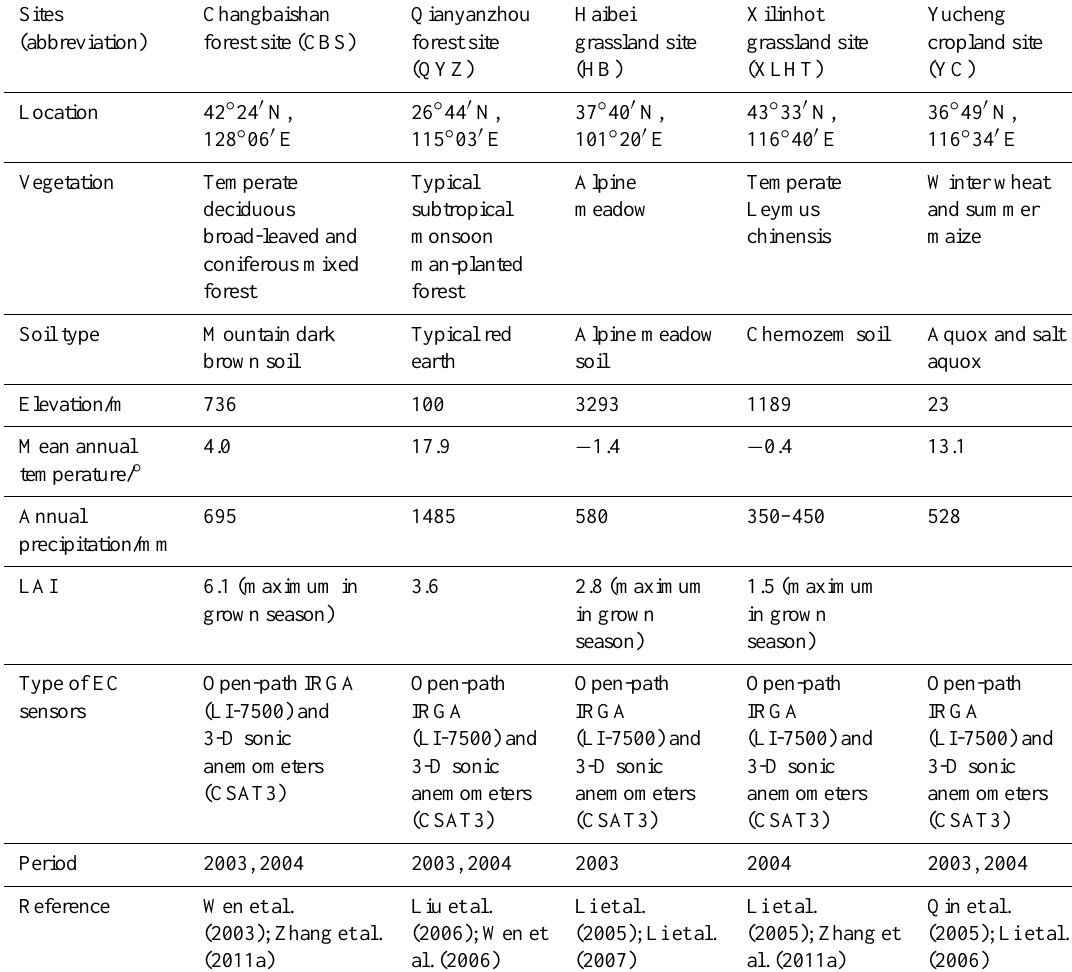
Table 2. ChinaFlux sites at which ET data were used for validating the BEPS model.